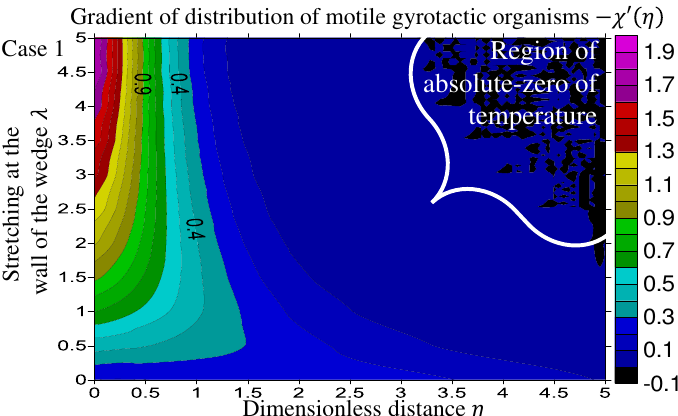
Figure 11. Distribution of motile gyrotactic organisms within the entire domain χ ( η ) with λ when λ = 0—case